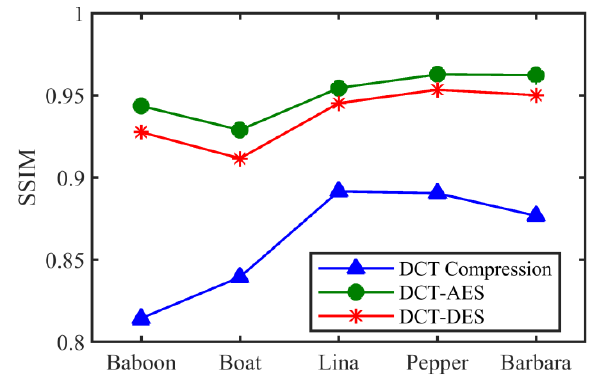
Figure 9 . Graphical representation of comparison of SSIM